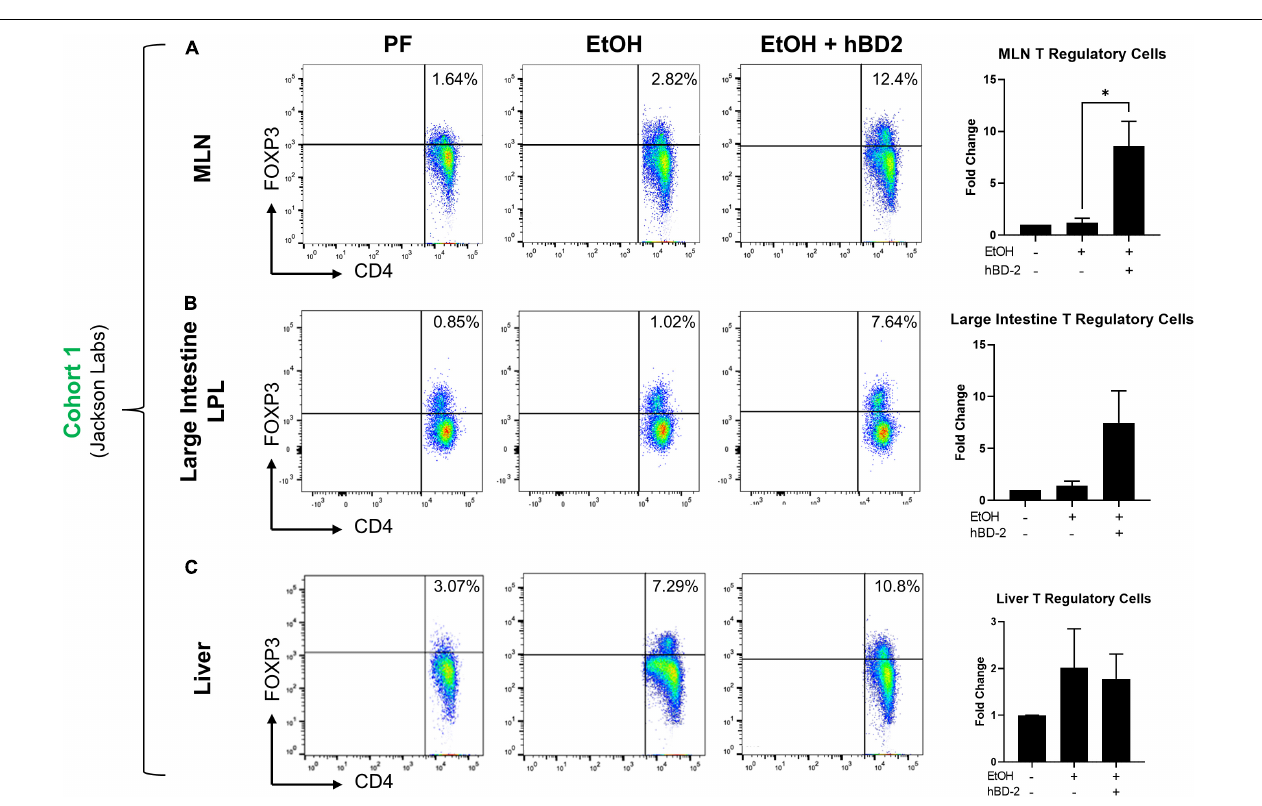
FIGURE 5 | Gut immunomodulatory effects of hBD-2 on Treg populations. Relative abundance of Tregs in EtOH-fed mice relative to pair-fed mice was determined in the mesenteric lymph nodes (A) , large intestine lamina propria (B) , and liver (C) in Cohort 1 animals. For each tissue, representative dot plots for each group are shown on the left (as determined by distance from mean), with percentages of FOXP3-positive cells displayed in the upper-right-hand quartile, and overall quantitation for the whole group shown on the right. Data are reported as mean ± standard error of the mean. * p < 0.05.